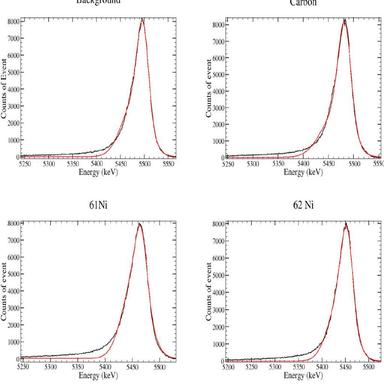
The energy spectrum of 61Ni, 62Ni, carbon and empty background (in order) with the energy channel along the x-axis and the counts of event along the y-axis.